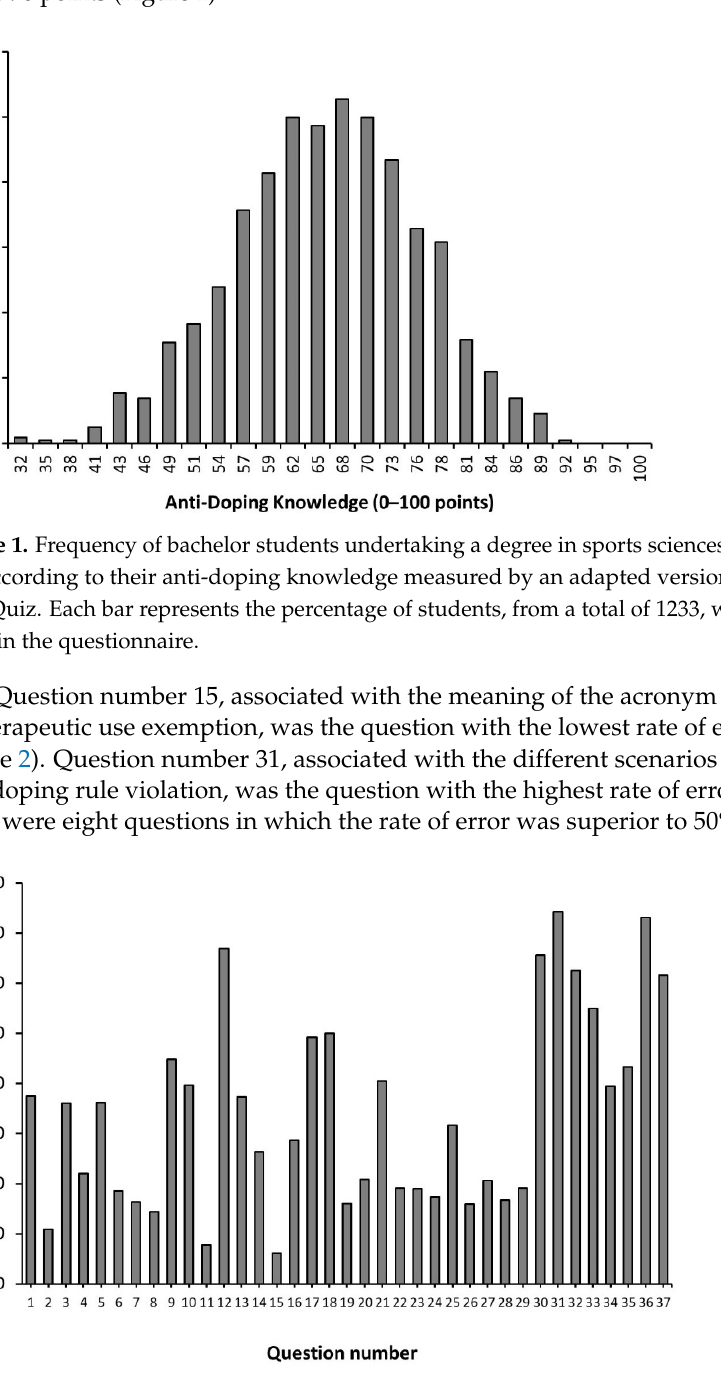
Figure 2. Rate of error in the questions of the adapted version of the WADA Play True Quiz in Spanish bachelor students undertaking a degree in sports sciences. Each bar represents the percentage of students, from a total of 1233, who chose a wrong answer for each of the 37 questions of the questionnaire.